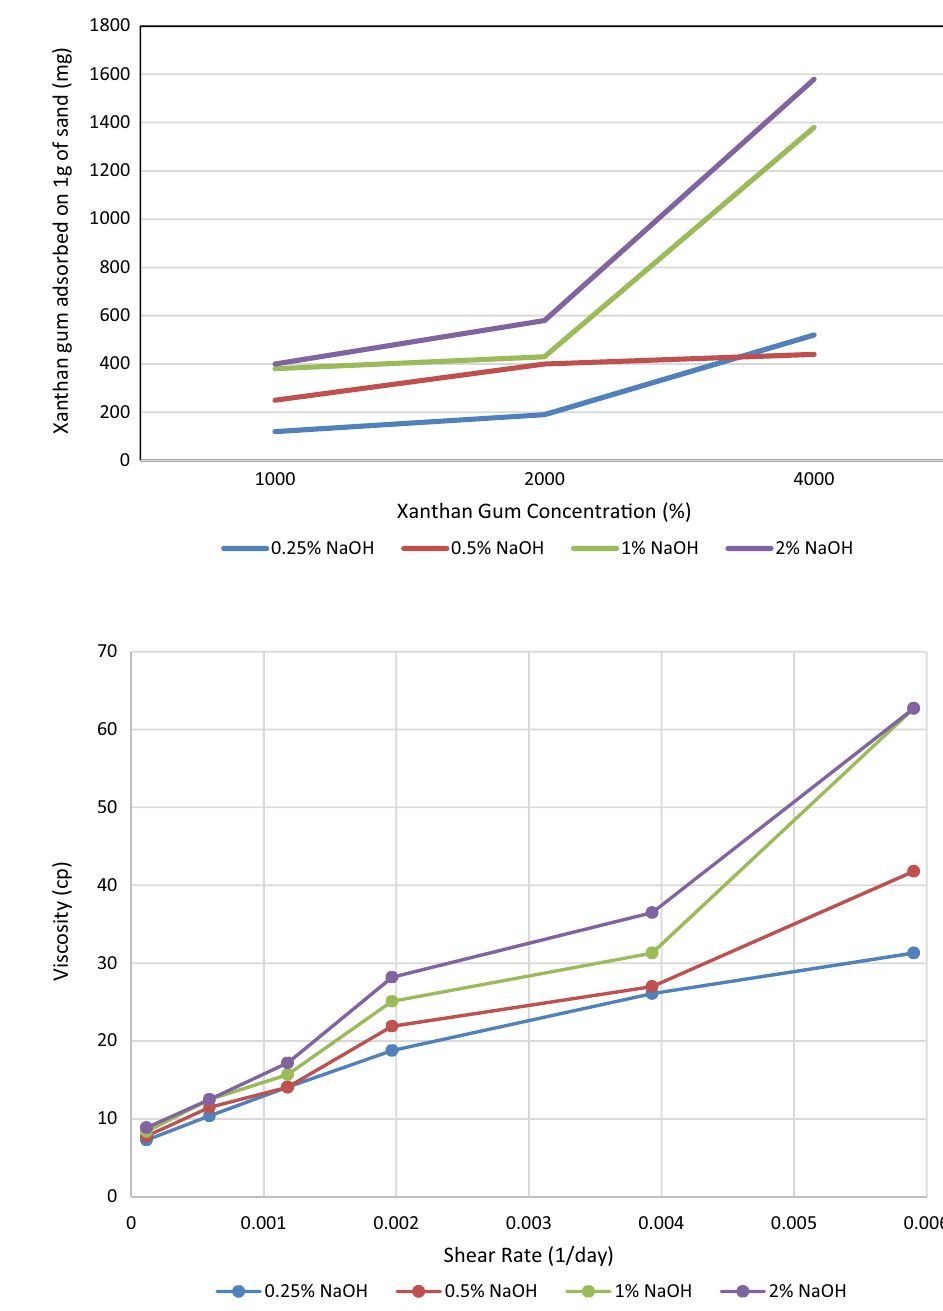
Fig. 7 Variation in the amount of xanthan gum adsorbed on 1 g of sand for different NaOH